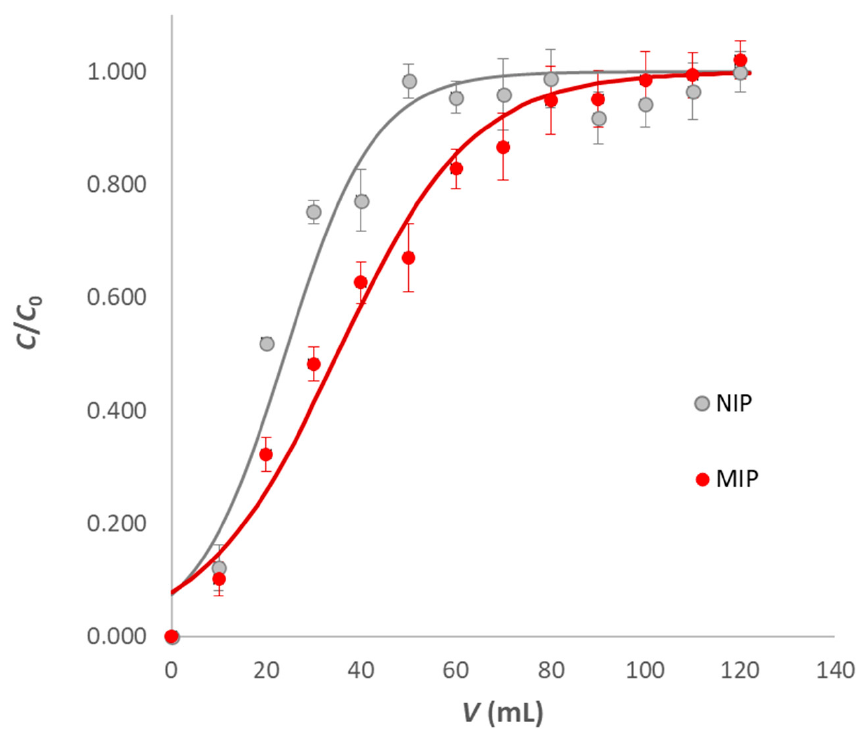
Figure 6. Breakthrough curves of IRB on the washed MIP-polyHIPE (1:15, red dots) and NIP-polyHIPE (grey dots). Experimental conditions: 120 mL 60 µ M IRB solution (pH 5, 0.1 M acetate buffer), 6 cm 3 SPE cartridge, 300 mg sorbent and flow rate 0.5 mL min − 1 . Continuous lines are the fitting by the Bohart–Adams model. Experimental points are reported as average values of five replicates, and the error bars correspond to the standard deviation.